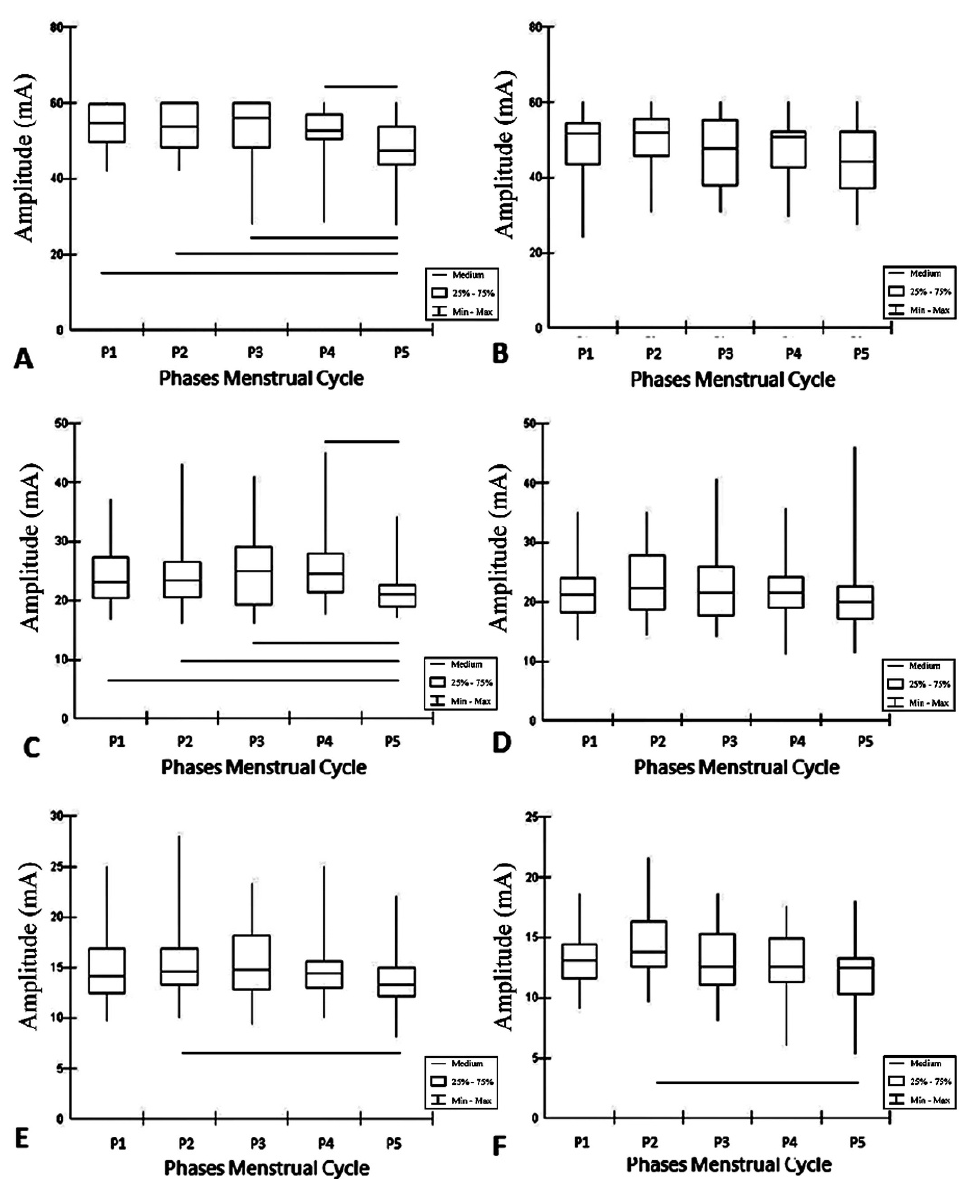
Figure 2 - The motor threshold (MT) across the following five phases of the menstrual cycle (MC): menstrual (P1), follicular (P2), ovulatory (P3), luteal (P4) and premenstrual (P5). A current of 2,500 Hz was applied in phases of 20 m s (A and B), 50 m s (C and D) and 100 m s (E and F). A, C and E represent the non-oral contraceptive group (NOCG), and B, D and F represent the oral contraceptive group (OCG). The connections indicate statistical significance ( p